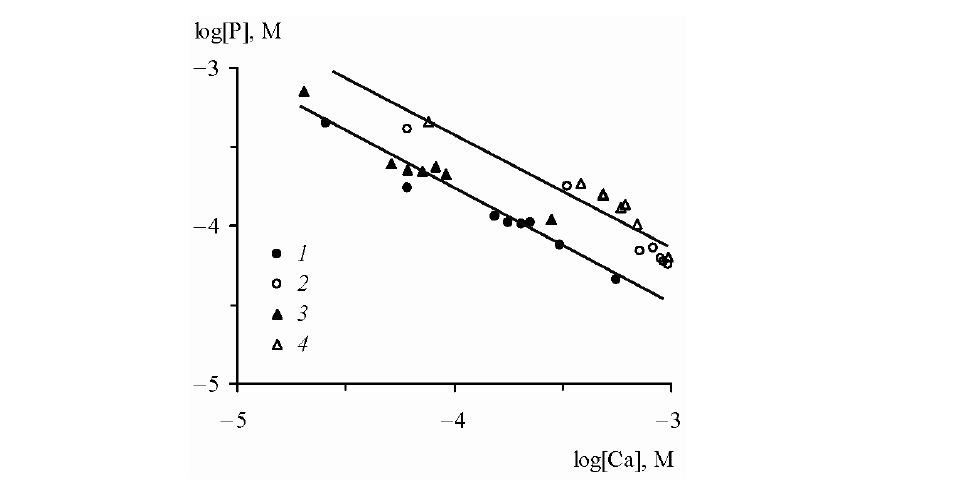
Table 4. Proportionality coefficient k in Equation (4) as a function of solution